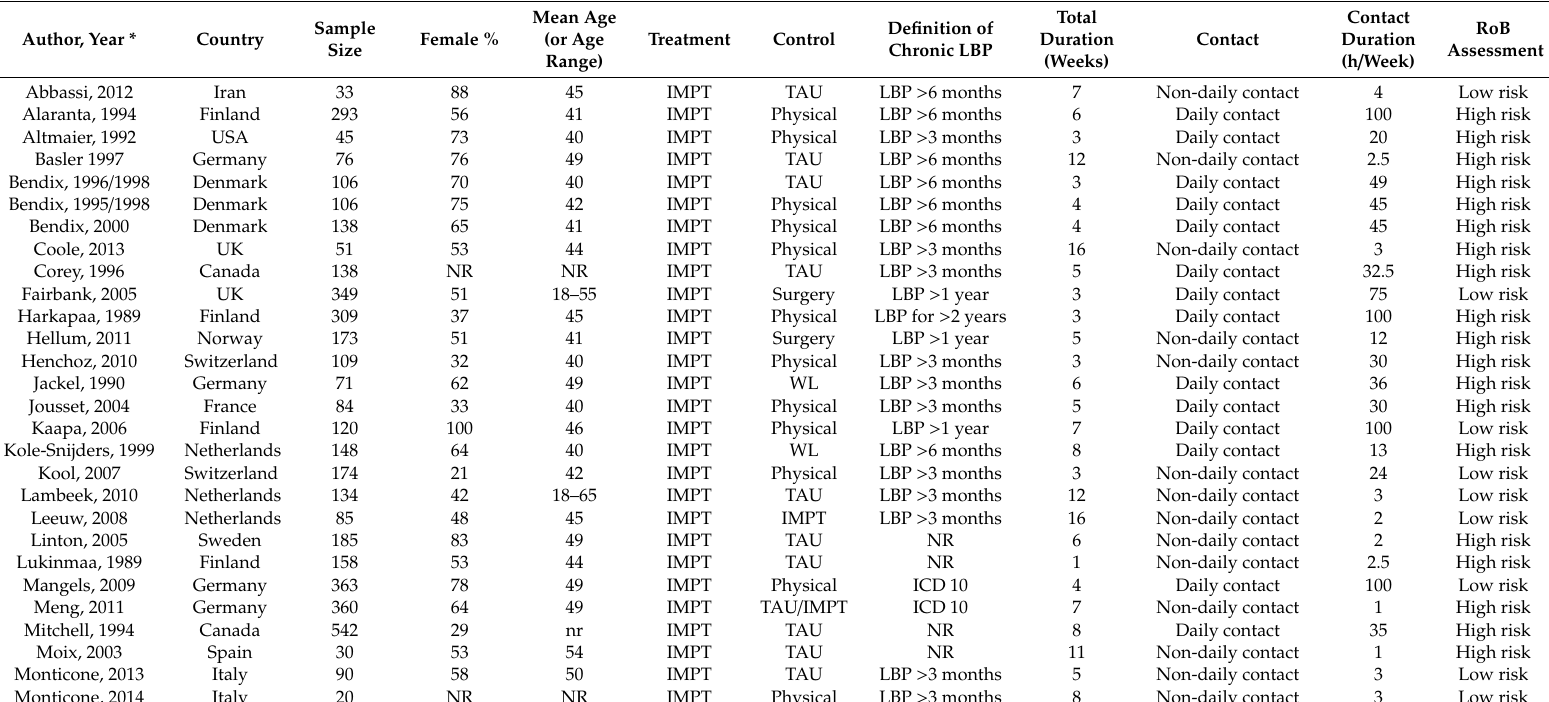
Table 1. Characteristics of included